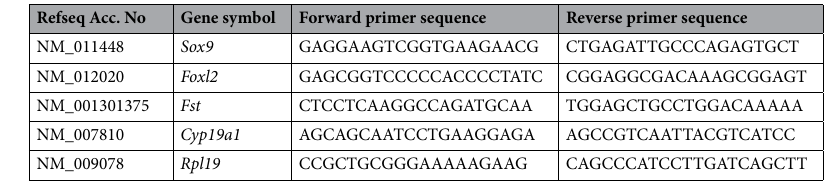
Table 1. Primer sets used for